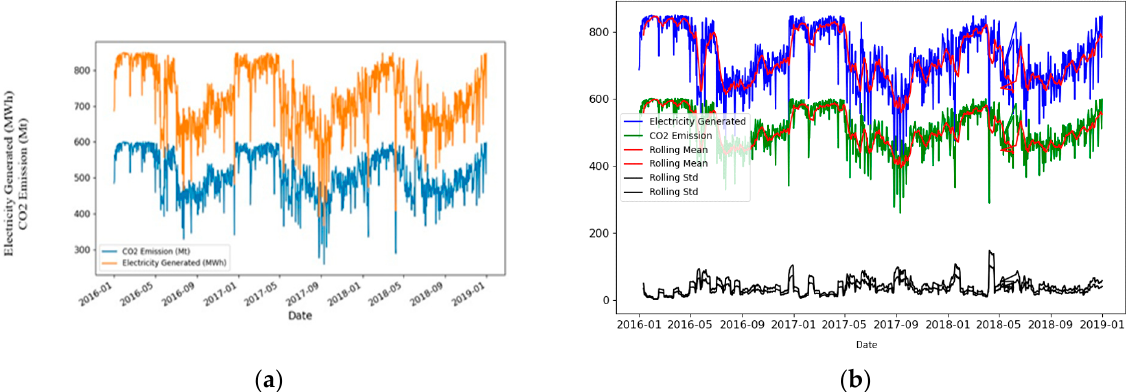
Figure 3. Test results ( a ) based on the original data, and the ( b ) overall increasing trend in the data along with some seasonal variations.